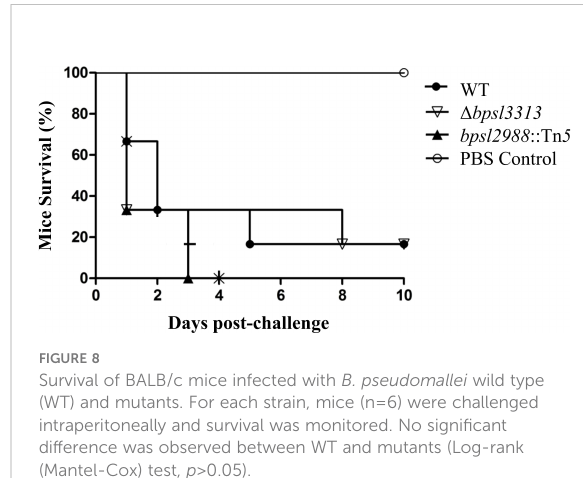
FIGURE 8 Survival of BALB/c mice infected with B. pseudomallei wild type (WT) and mutants. For each strain, mice (n=6) were challenged intraperitoneally and survival was monitored. No signi fi cant difference was observed between WT and mutants (Log-rank (Mantel-Cox) test, p >0.05).